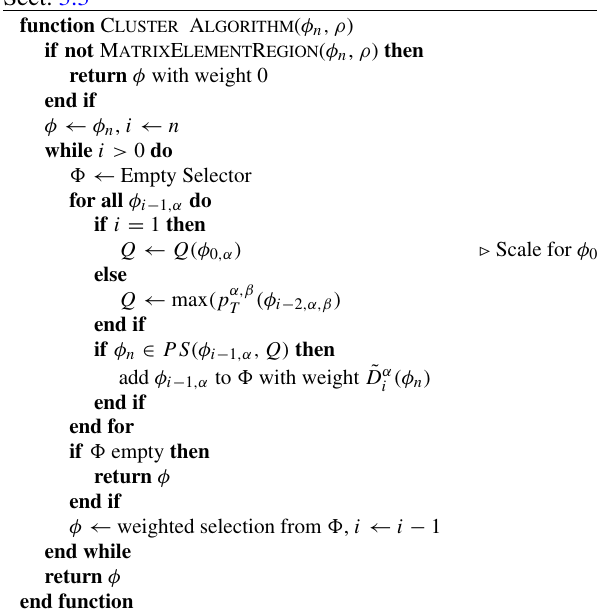
Algorithm 3.1 The clustering algorithm employed to